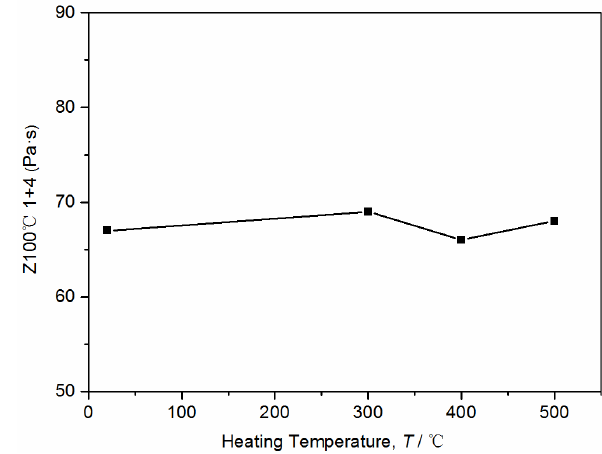
Figure 12: Effect of high temperature treatment on Mooney viscosity for carbon black filled SBR